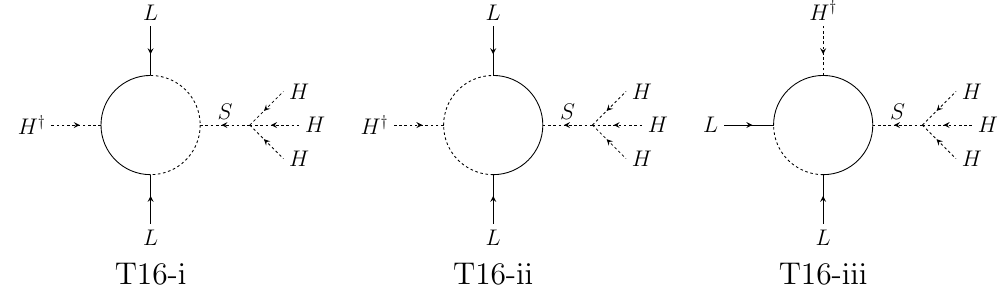
Figure 19 . Diagrams that lead to a genuine d = 7 1-loop neutrino mass for which the largest representations of SU(2) L is at least a quadruplet. All these diagrams contain S = 4 S hypercharge of the scalar S ensures the absence of a d = 5 1-loop neutrino mass.